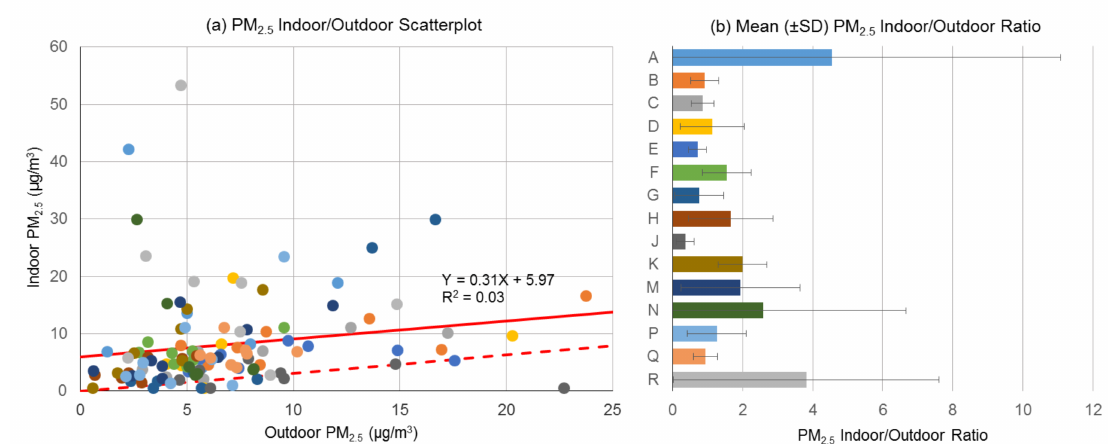
Figure 3. ( a ) Scatterplot of indoor vs. outdoor PM 2.5 mass concentrations and linear regression (dashed line is the regression line with the intercept removed); and ( b ) bar plot of mean ( ± SD) PM 2.5 indoor/outdoor ratios per house. The bar color for each home in ( b ) corresponds to the marker color in ( a